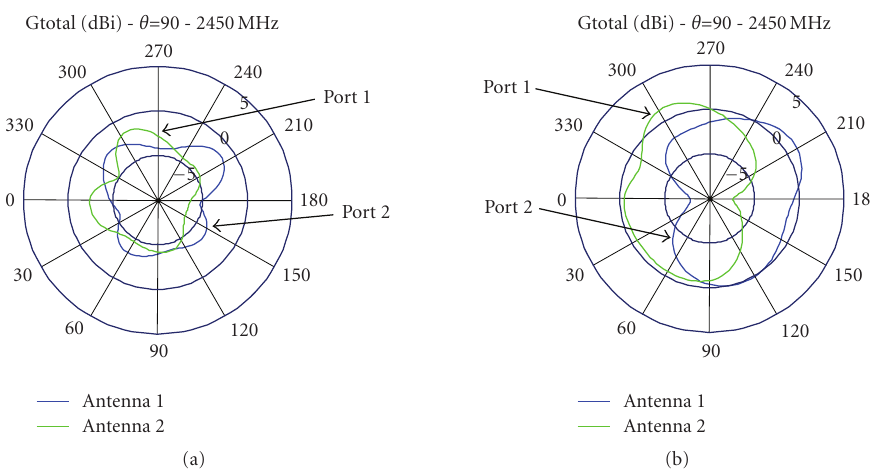
Figure 2: Example of antenna azimuthal gain pattern produced by: (a) two closely spaced monopoles and (b) single element iMAT antenna of similar size showing substantially di ff erent far-field pattern compared to (a).